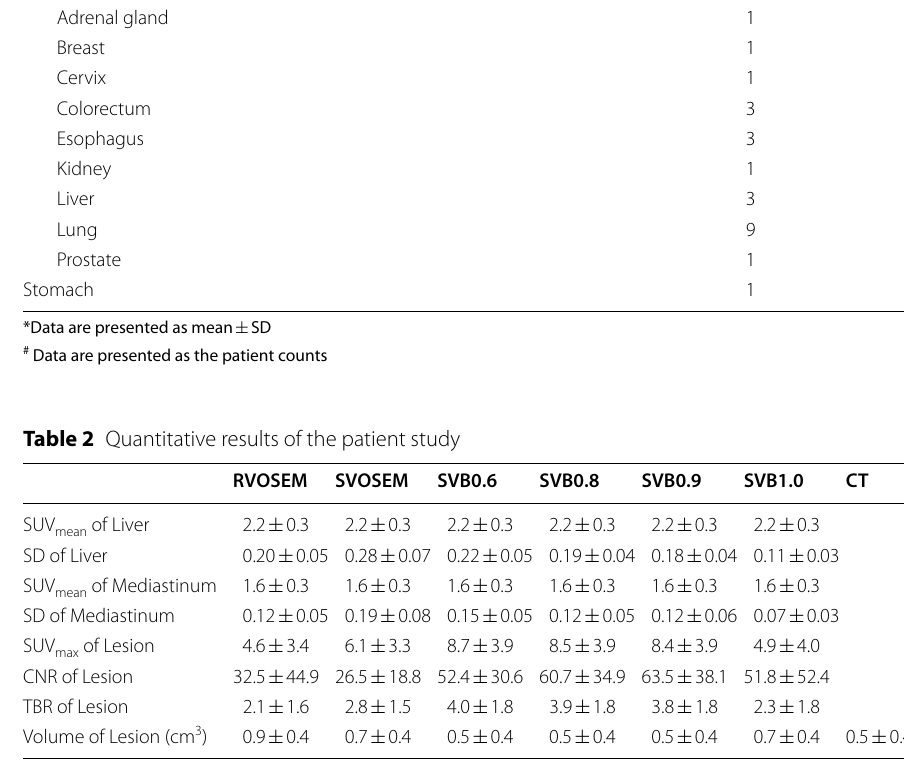
* Data are presented as mean